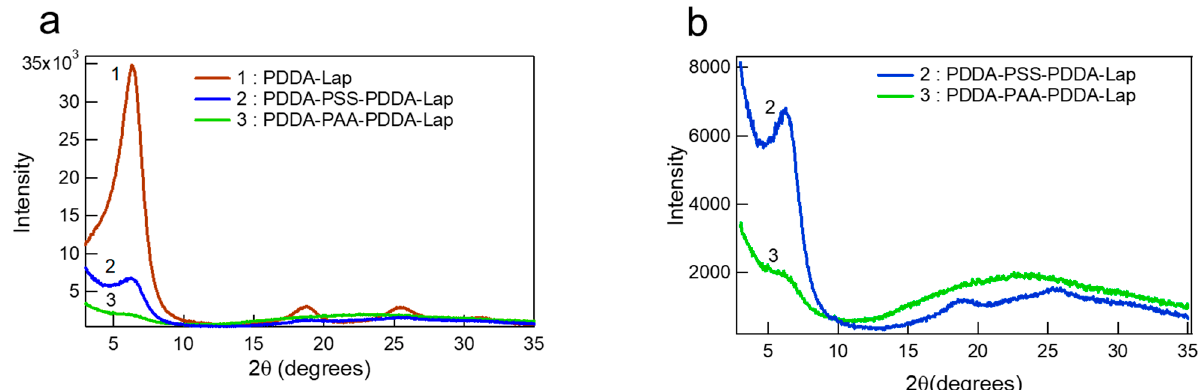
Figure 3. ( a ) XRD patterns of 360-layer PDDA-Laponite, 180-layer PDDA-PSS-PDDA-Laponite, and 180-layer PDDA-PAA-PDDA-Laponite multilayers. ( b ) The patterns of PDDA-PSS-PDDA-Laponite and PDDA-PAA-PDDA-Laponite multilayers are plotted at a smaller intensity range for better visualization of the peaks.